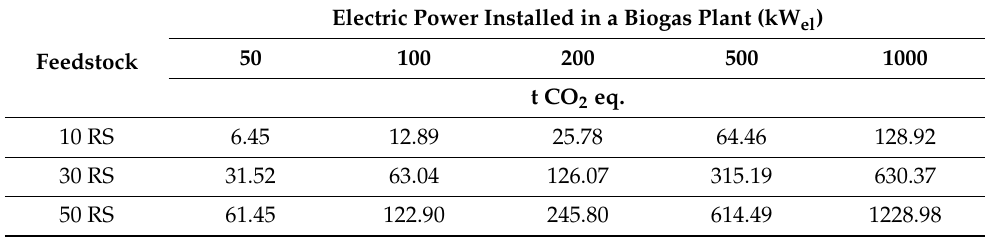
Table 7. CO 2 eq. emissions avoided by reducing the area for maize cultivation.